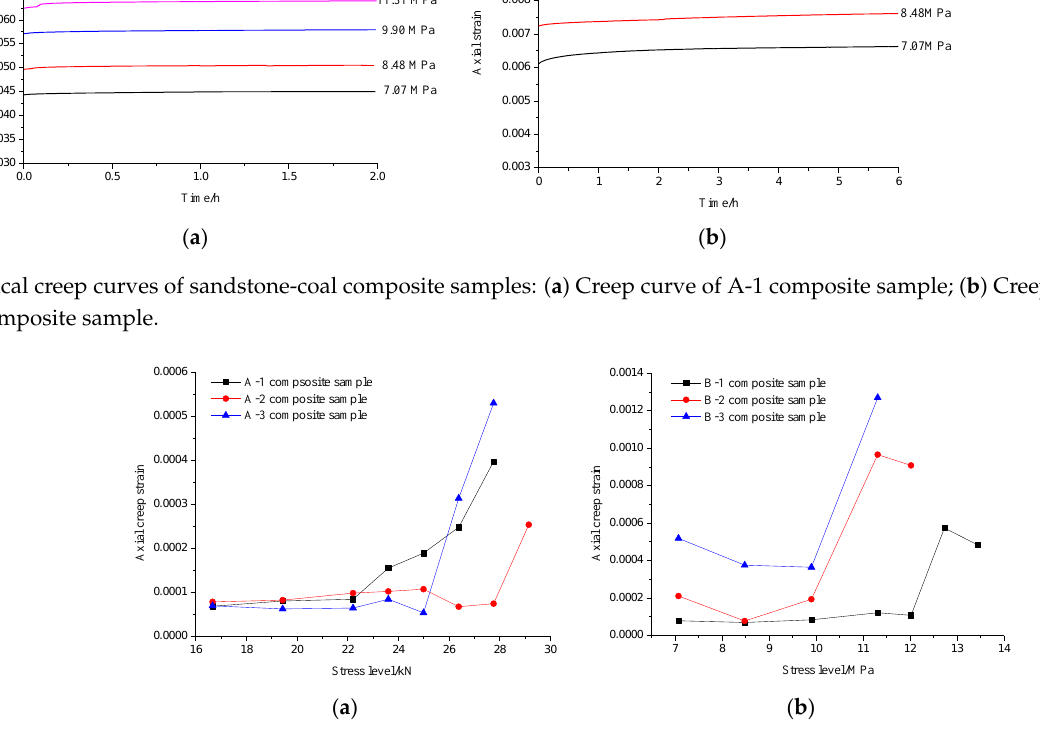
Figure 11. Axial creep strains of sandstone-coal composite samples at different stress levels: ( a ) Axial